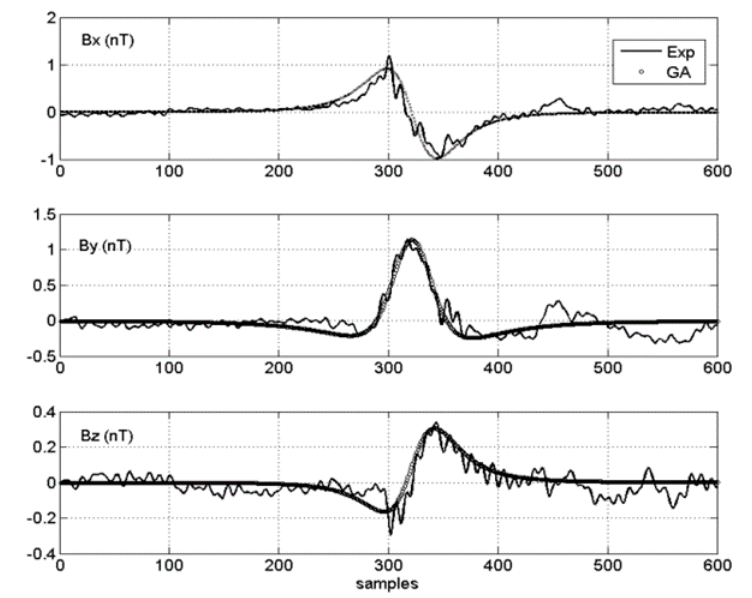
Figure 9. Clean signal (SNR 1): Experimental vs. GA solution.